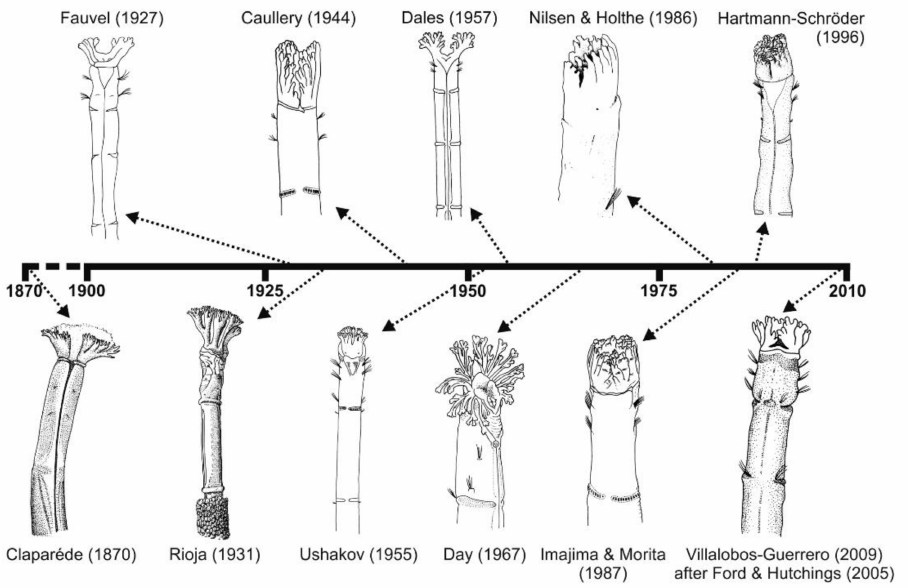
Figure 19. Selection of illustrations of anterior body end of Owenia fusiformis through time. All redrawn from